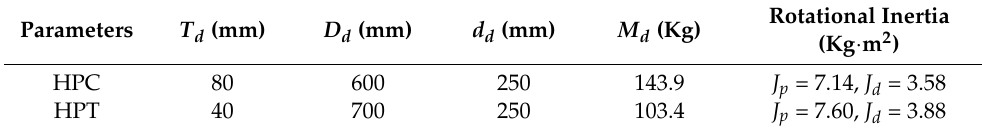
Table 2. Parameters of two disks.